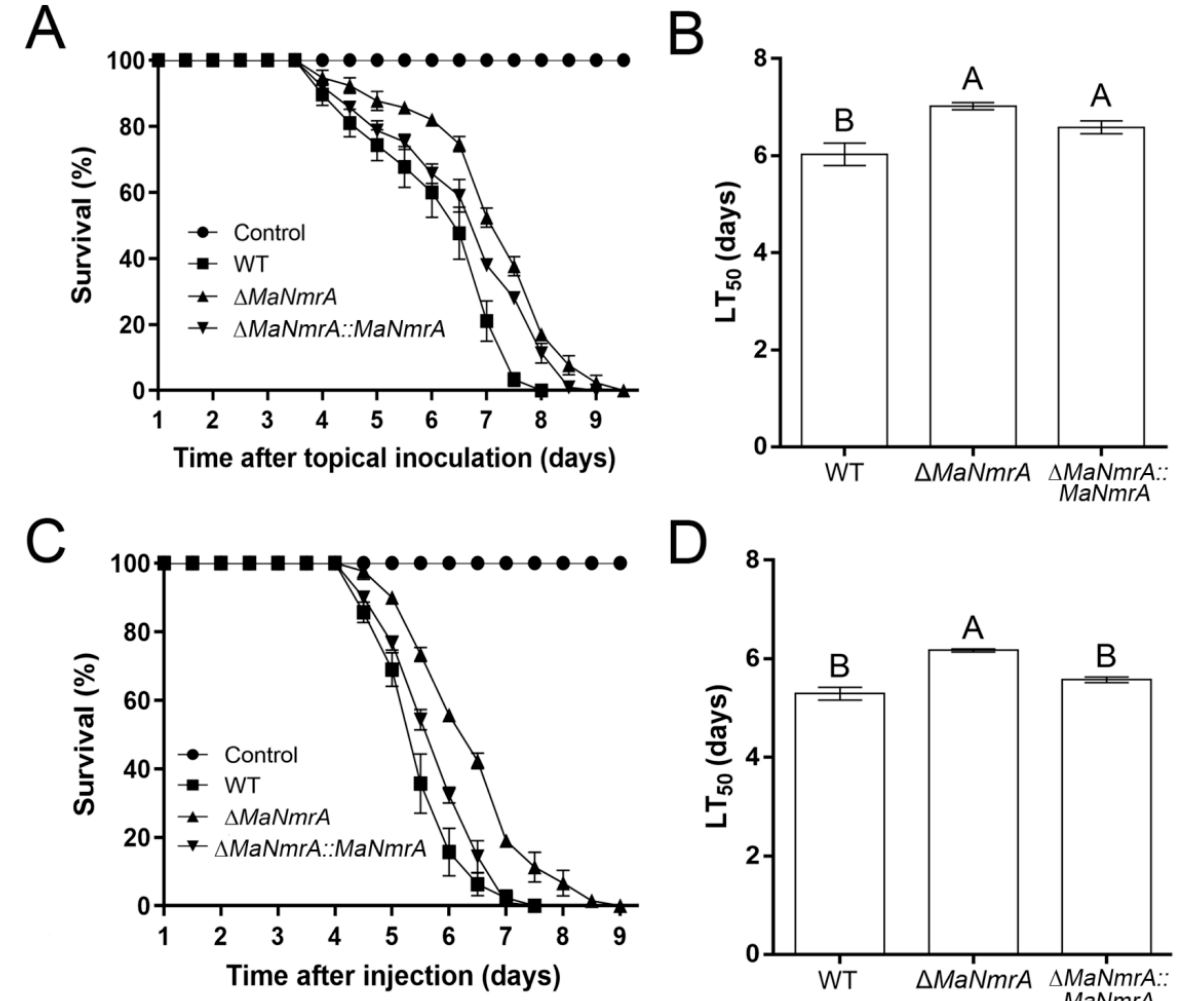
Figure 6. Disruption of MaNmrA decreased the virulence of M. acridum. ( A ) Survival of locusts respectively infected with WT, Δ MaNmrA, or ∆ MaNmrA::MaNmrA strain via topical inoculation. ( B ) The LT 50 s of WT, Δ MaNmrA and ∆ MaNmrA :: MaNmrA strains in topical inoculation. ( C ) Survival of locusts respectively infected with WT, Δ MaNmrA or ∆ MaNmrA :: MaNmrA strain via intra-hemocoel injection. ( D ) The LT 50 s of WT, Δ MaNmrA and ∆ MaNmrA :: MaNmrA strains in intra-hemocoel injection. Letters A and B above graph indicate significant differences ( p < 0.01, Tukey’s HSD).